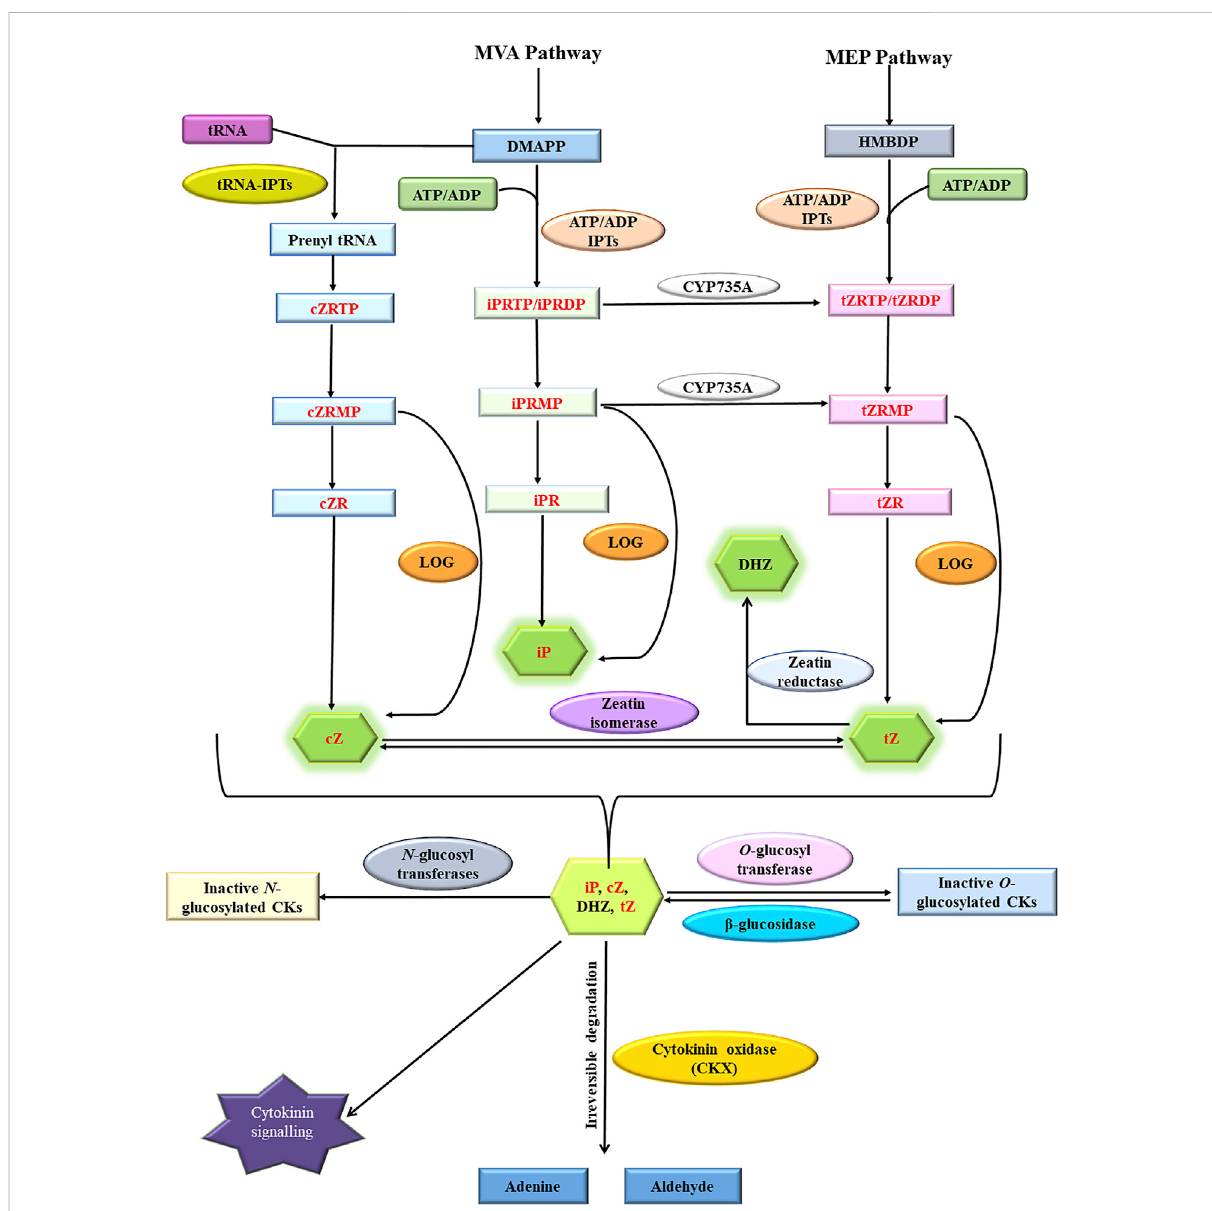
FIGURE 1 Cytokinin homeostasis maintenance pathway involving in situ cytokinin biosynthesis (catalyzed by ATP-ADP IPTs and tRNA-IPTs), activation (catalyzed by speci fi c phosphoribohydrolases encoded by LOG genes), irreversible inactivation (catalyzed by N -glucosyltransferases), reversible inactivation (catalyzed by O -glucosyltransferases), reactivation (catalyzed by β -glucosidases) and irreversible degradation (catalyzed by cytokinin oxidase/dehydrogenases). Cytokinin oxidase/dehydrogenases substrates are highlighted in red (Modi fi ed from Frébort et al., 2011b; Kieber and Schaller, 2014; Hluska et al.,